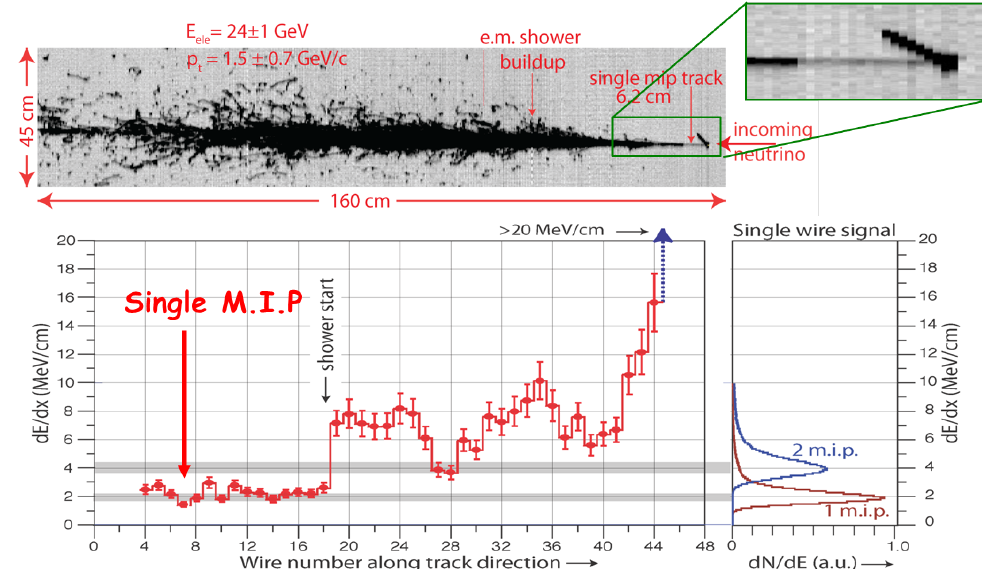
Figure 11. ( Top ): CNGS high energy ν e CC candidate, with a CC electron resulting in a e.m. shower and a highly ionizing proton emerging from the main neutrino interaction vertex. ( Bottom ): Energy loss as a function of the evolution of the CC electron from a single track to an e.m. shower: the CC electron is a m.i.p. track for the first 6 cm, then the e.m. shower start its development.